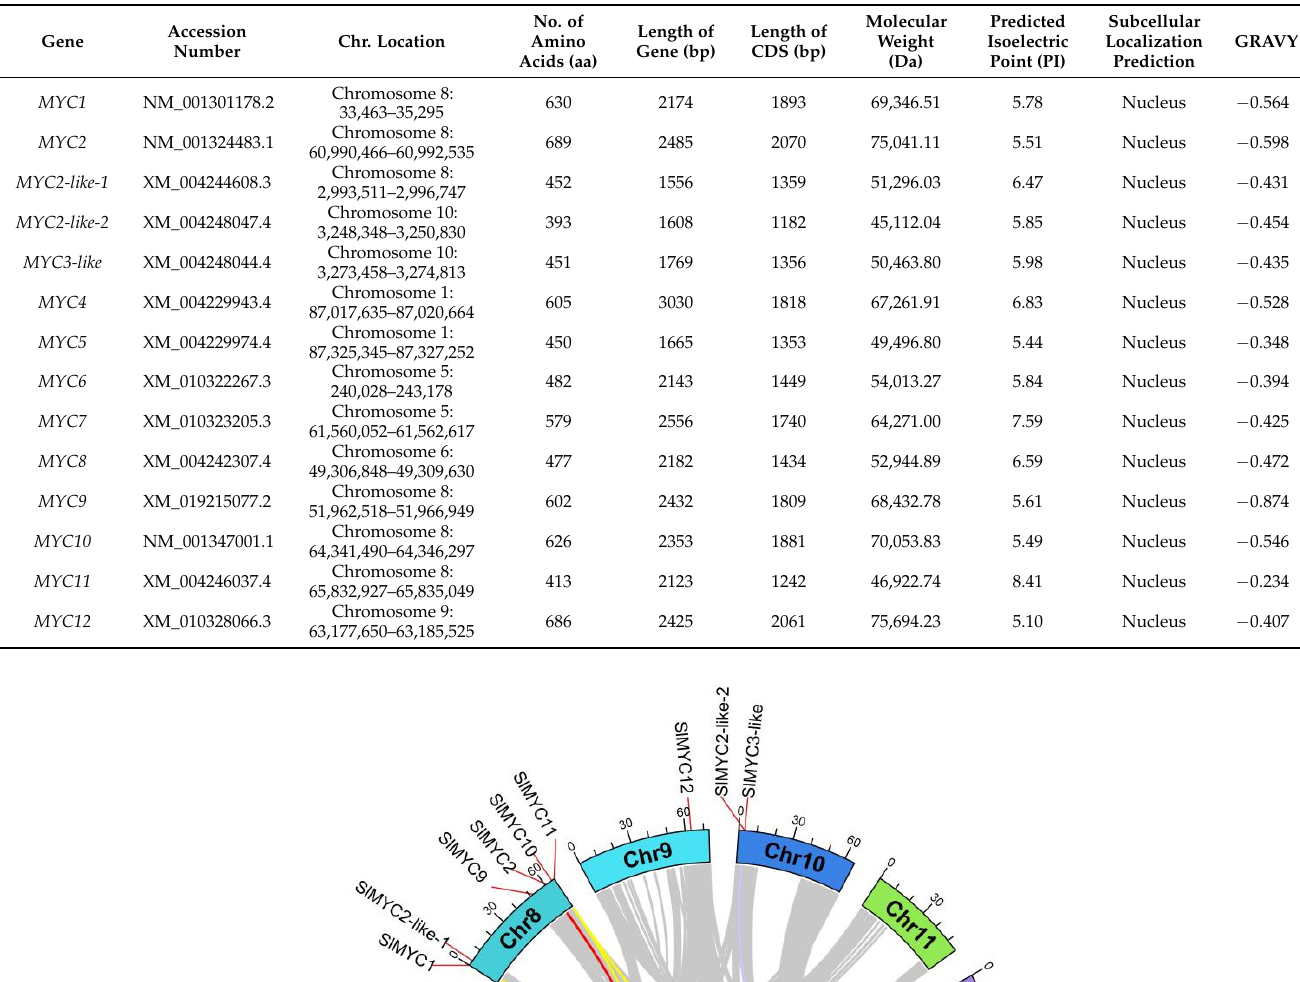
Table 1. Characteristics of the MYC gene family in Solanum lycopersicum . The bioinformatics online software ExPASy (https://web.expasy.org/protparam/) (accessed on 21 September 2021). was used to predict the physical and chemical properties of 14 tomato MYC family genes at the chromosomal positions and their corresponding protein sizes, molecular weights, and isoelectric and subcellular localization prediction points.